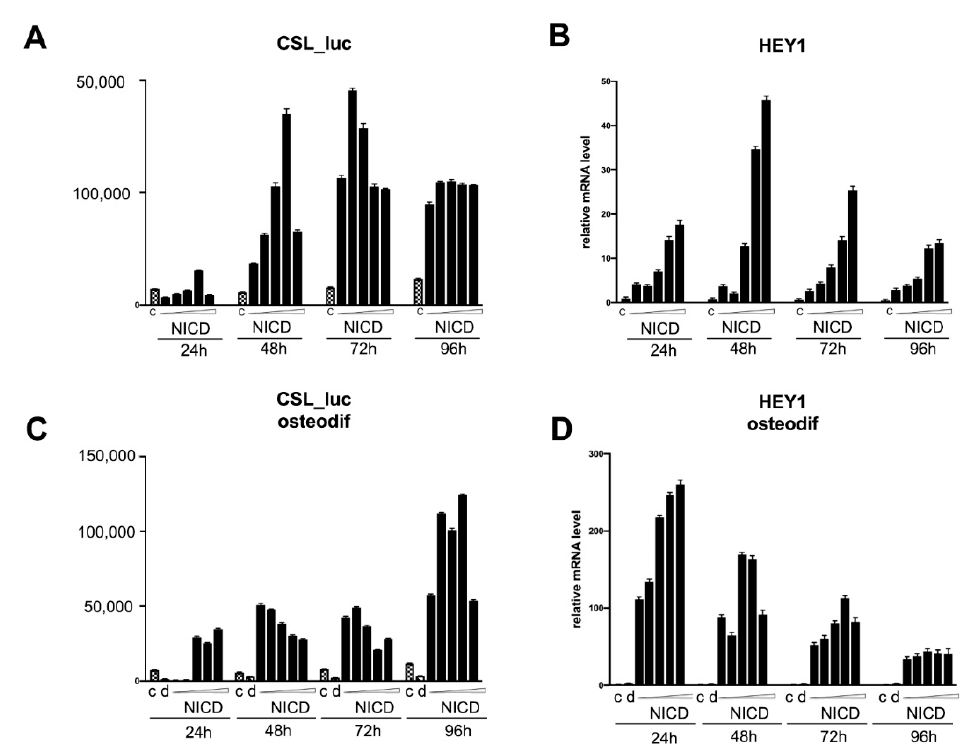
Figure 4. Analysis of the dose-dependent Notch activation influence on CSL promoter activity ( A , C ) and HEY1 transcription ( B , D ) in mesenchymal stem cells (MSCs) of adipose tissue in non-osteogenic ( A , B ) and osteogenic conditions ( C , D ). The cells were transduced with the construct bearing CSL-luciferase reporter and subsequently with various doses of NICD-bearing viruses, and were analyzed in non-osteogenic and osteogenic conditions after indicated periods of time.